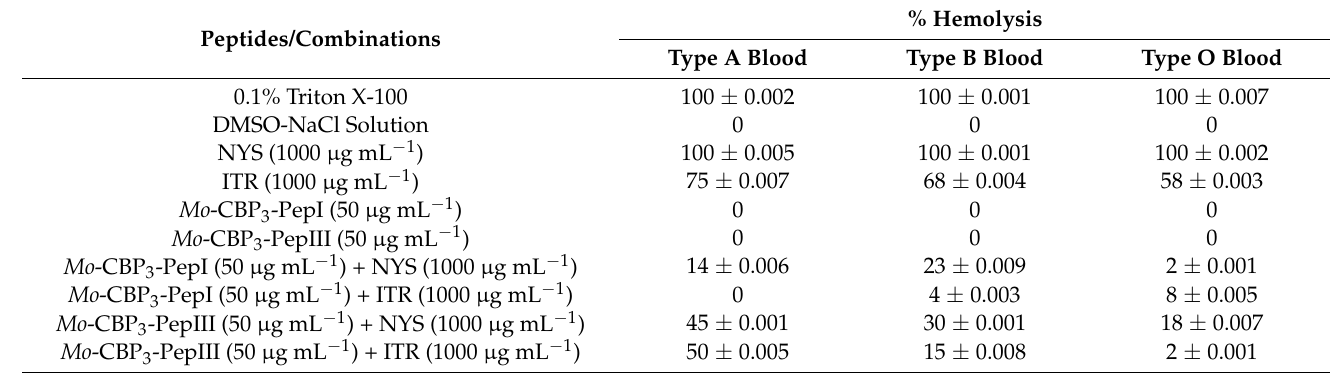
Table 1. Hemolytic activity of Mo -CBP 3 -PepI and Mo -CBP 3 -PepIII, antifungal drugs, and combined solutions on human red blood